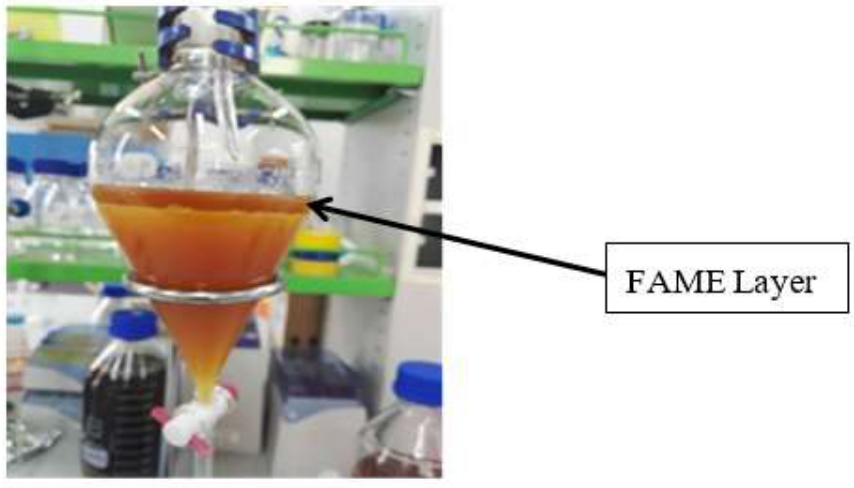
Figure 2. Phase separation after transesterification.